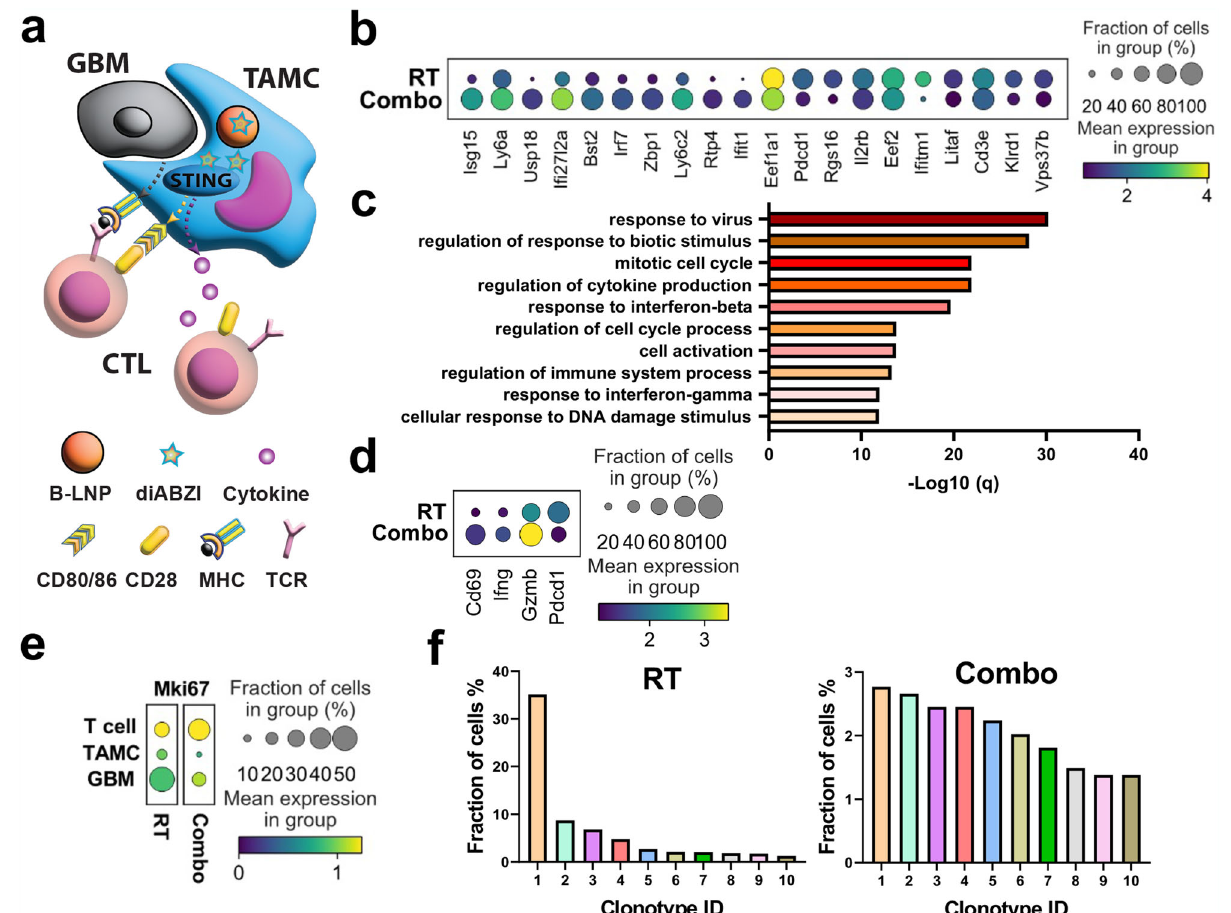
Fig. 5 | Nanoparticle-mediated TAMC reprogramming induces transcriptomic changes of T cells in murine gliomas. a Schematic representation of the inter- action between B-LNP/diABZI-reprogrammed TAMC and T cell. The scheme was generated using Adobe Illustrator. b – f Single-cell RNA sequencing analysis of T cells from CT-2A brain tumors in C57 mice received radiotherapy (RT) or RT+B- LNP/diABZI combination therapy (referred to as Combo) ( n =5 mice pooled per sample). b Unbiaseddifferentialexpressionanalysisindicatingtopupregulatedand